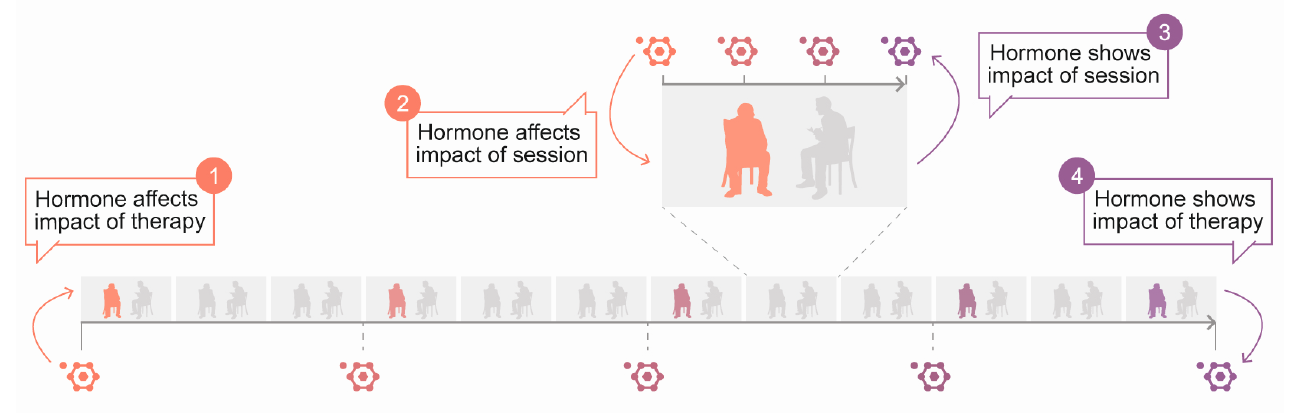
Figure 1. Framework for the investigation of hormones in psychotherapy. Direction: hormones as predictors (1, 2) or indicators (3, 4) of therapeutic changes. Level: treatment (1, 4) or session (2, 3).